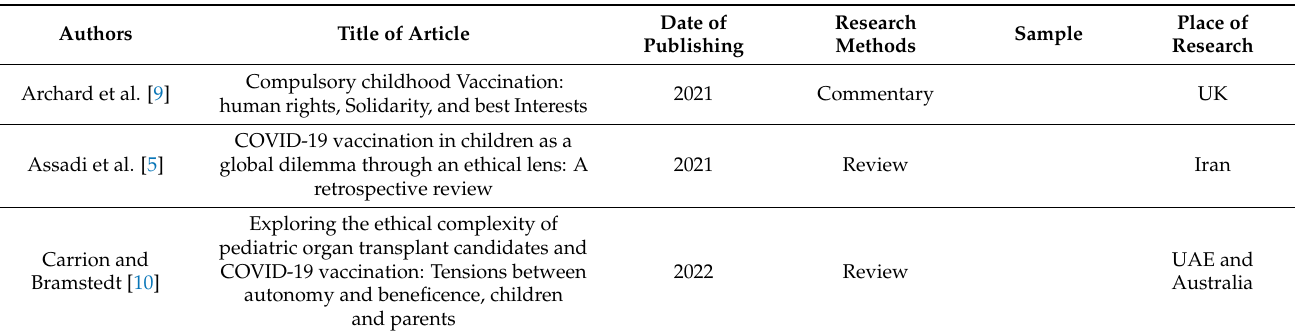
Figure 1. Showing the data screening and extraction with PRISMA. Table 1. Demographics of included